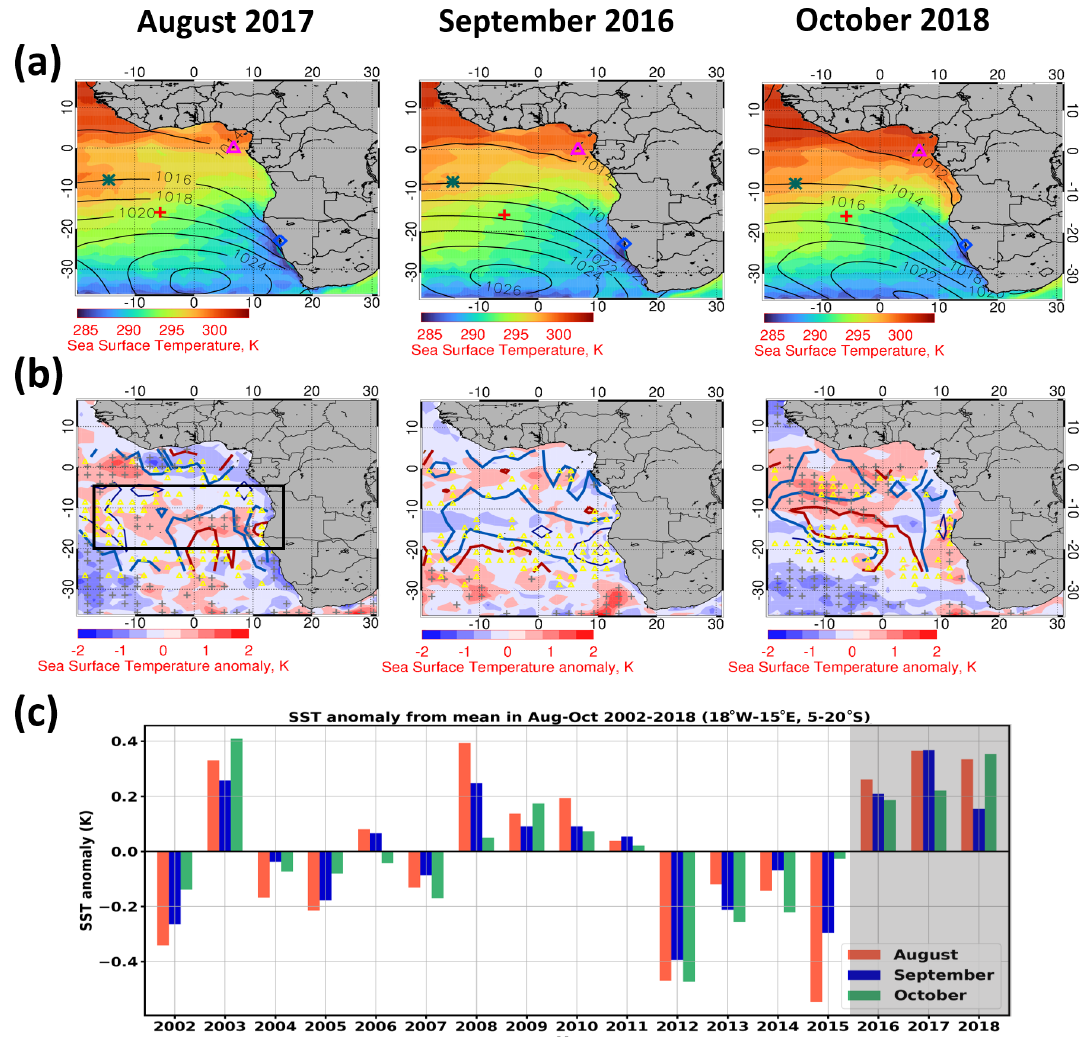
Figure 9. Maps of (a) SST monthly mean (shading; Kelvin) overlain by sea level pressure (SLP; black contour; hectopascals), and (b) SST anomaly from the climatological mean (2002–2018) overlain by a low-CF anomaly (contours, from thick to thin, in blue ( − 0.02, − 0.07, and − 0.12) and dark red ( + 0.02, + 0.07, and + 0.12); percent). (c) Time series of SST anomaly averaged over the box region (18 ◦ W–15 ◦ E, 5– 20 ◦ S, black) for the ORACLES deployment months (August 2017, September 2016, and October 2018). The markers in panel (a) represent São Tomé (magenta triangle), St. Helena island (red cross), Ascension Island (green asterisk), and Walvis Bay (light blue diamond). The SST anomaly is averaged at ∼ 2.11 ◦ resolution, and the low-CF anomaly is smoothed by averaging at 2 ◦ (longitude) by 5 ◦ (latitude) to reduce the noise. The gray cross (yellow triangle) indicates that the SST anomaly (low-CF anomaly) data are significant at the 85% confidence level. The SST monthly mean data are obtained by averaging SST hourly